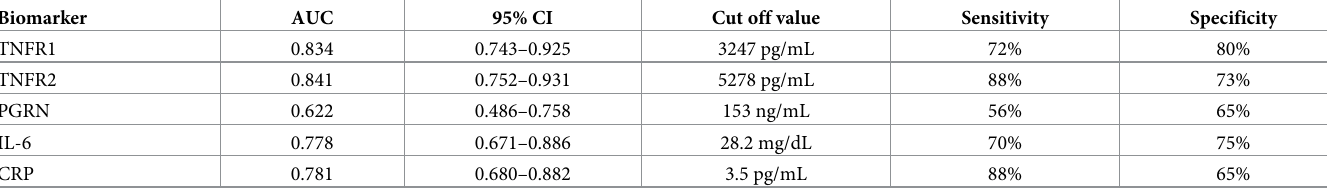
Table 5. Results of receiver operating characteristic analysis of promising markers for mortality of COVID-19. Biomarker